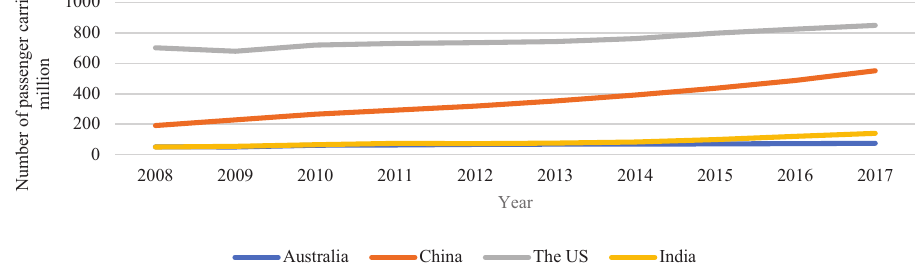
Figure 1. Air transport passenger carried number in Australia, China, The US and India from 2008 to 2017, number in